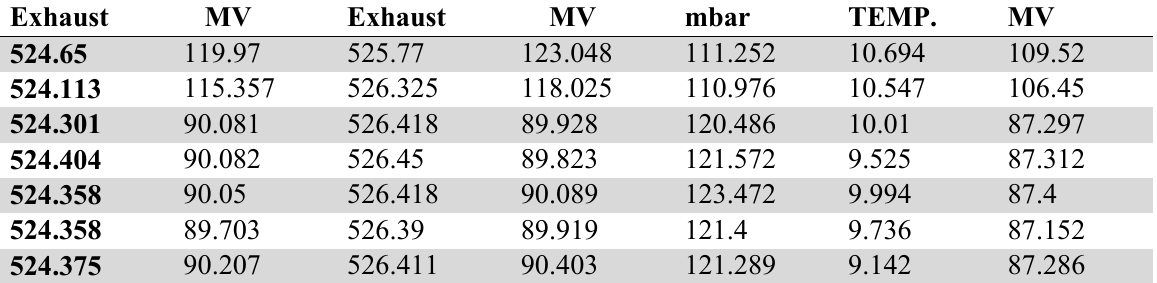
The processed data for GT and